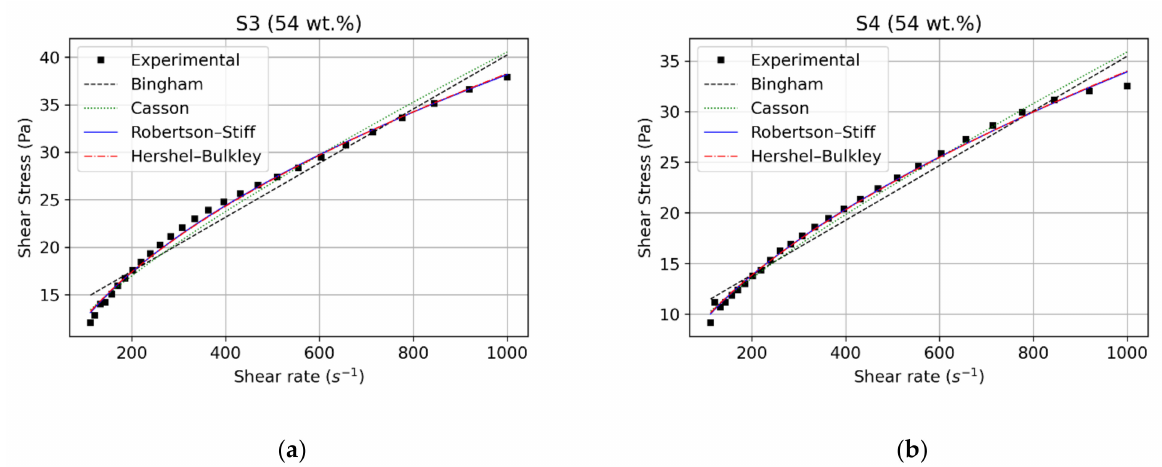
Figure 5. Comparison of rheological model fits for ( a ) S3 and ( b )